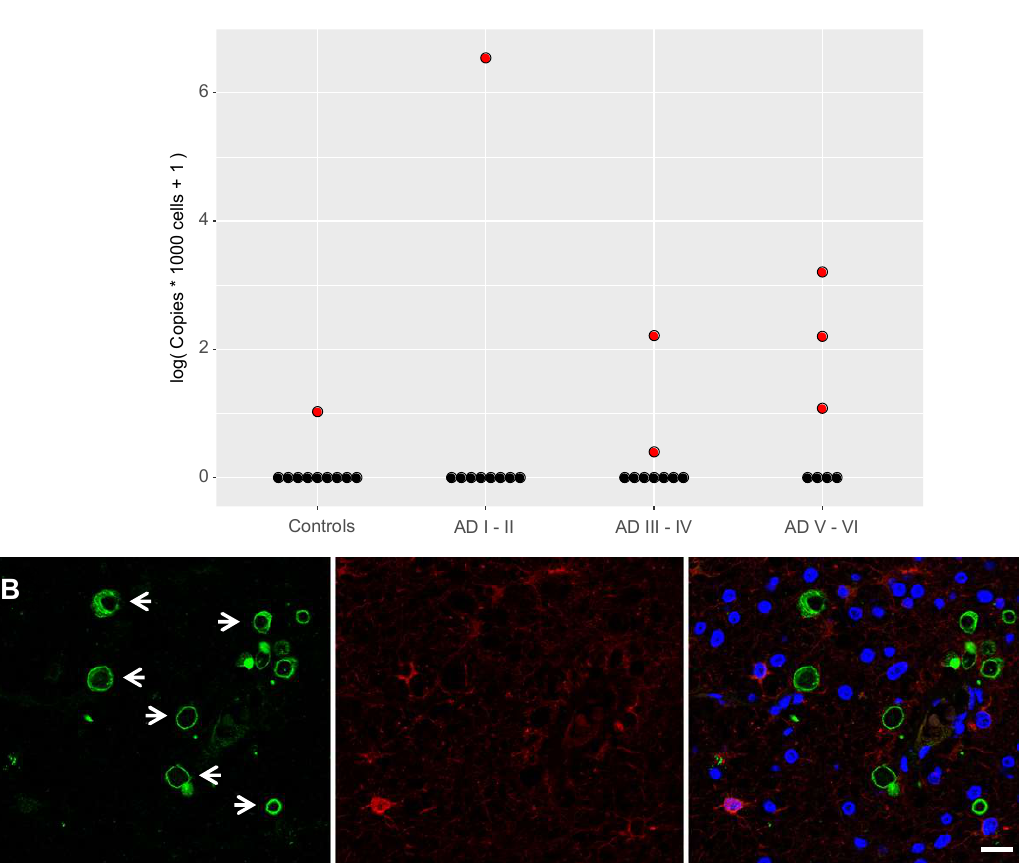
Figure 4. ( A ) qPCR quantification of HHV-6 number of copies per cell in cases of Alzheimer’s disease (AD) at different Braak and Braak stages (I–II, n = 9; III–IV, n = 9; V–VI, n = 7) and controls (n = 10) with primers designed against the U3 region. HHV-6 copy number per cell was determined by comparison with an LCL infected with the congenital form of the virus. The copy number of a reference LCL (NA18999), was determined to be 1 HHV-6 copy per cell in [11] using ddPCR. ( B ) Double-labelling immunofluorescence and confocal microscopy to mouse monoclonal anti-HHV-6 (Abcam ab128404, diluted 1/50; green), and rabbit anti- glial fibrillary acidic protein/GFAP (Diagnostic BioSystems RP014-S, diluted 1/400; red) antibodies. HHV-6 immunoreactivity is only found in the peripheral region of corpora amilacea (arrows) in the periventricular white matter of the temporal lobe in one case of AD stage V-VI and positive PCR. Nuclei are counterstained with DRAQ5 TM (blue); bar = 25 μm.